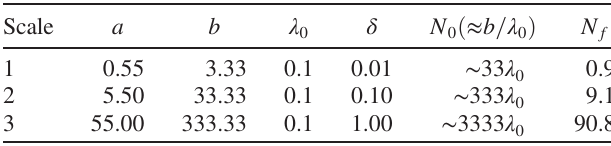
TABLE I. The three different scales considered during the present analysis: mildly overmoded (Scale-1), overmoded (Scale-2) and highly overmoded (Scale-3). Scale-3 is the struc- ture proposed for the LCLS THz transport problem. For each scale, N 0 indicates the structure period ( b ) measured in wave- lengths and N f ¼ a 2 = ð b λ 0 Þ is the Fresnel number. The values given for screen-thickness δ are example values to indicate the scaling. All shown dimensions are in